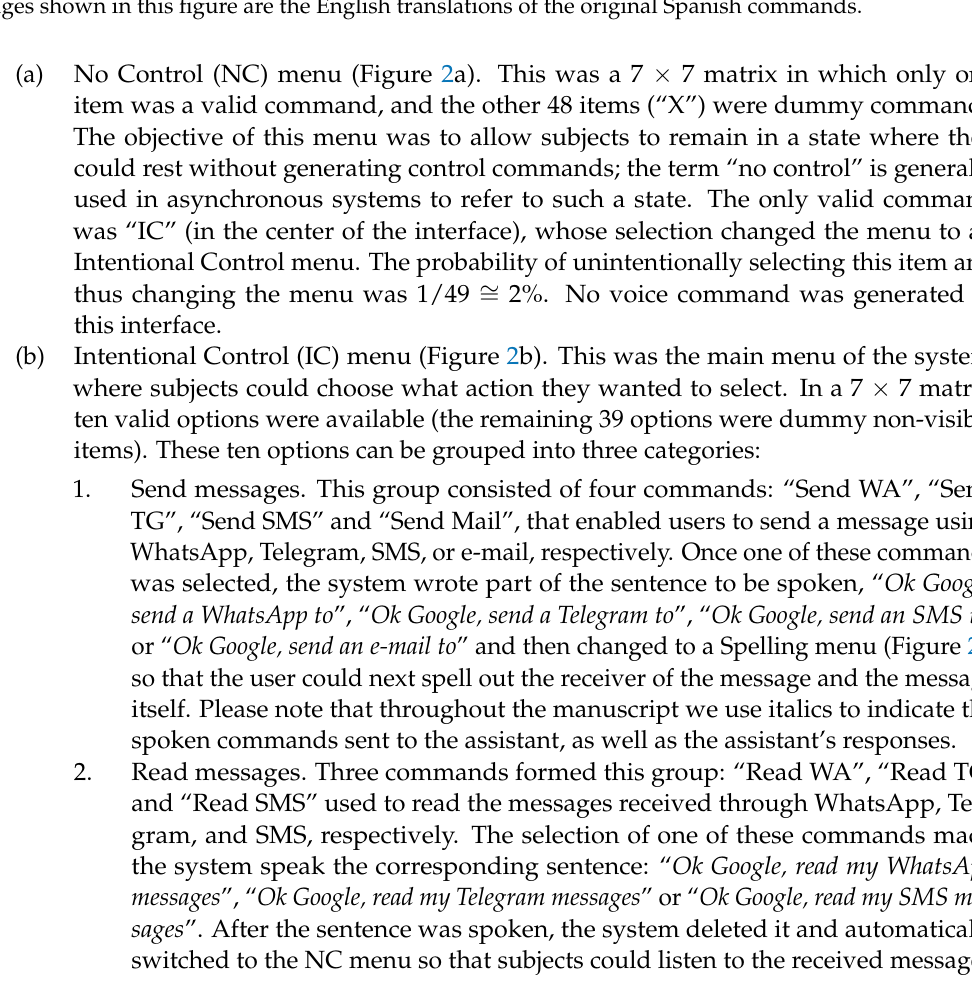
Figure 2. Navigation scheme between the four available menus: ( a ) No Control, ( b ) Intentional Control, ( c ) Spelling, ( d ) Confirmation. The images shown in this figure are the English translations of the original Spanish